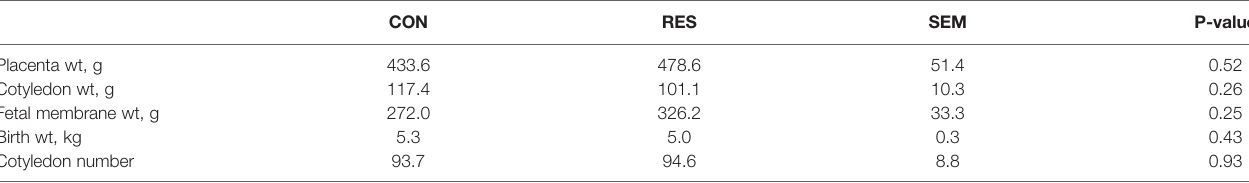
TABLE 2 | Placental weight, cotyledon weight, birth weight, fetal membrane weight, and cotyledon number. CON RES SEM P-value Placenta wt, g